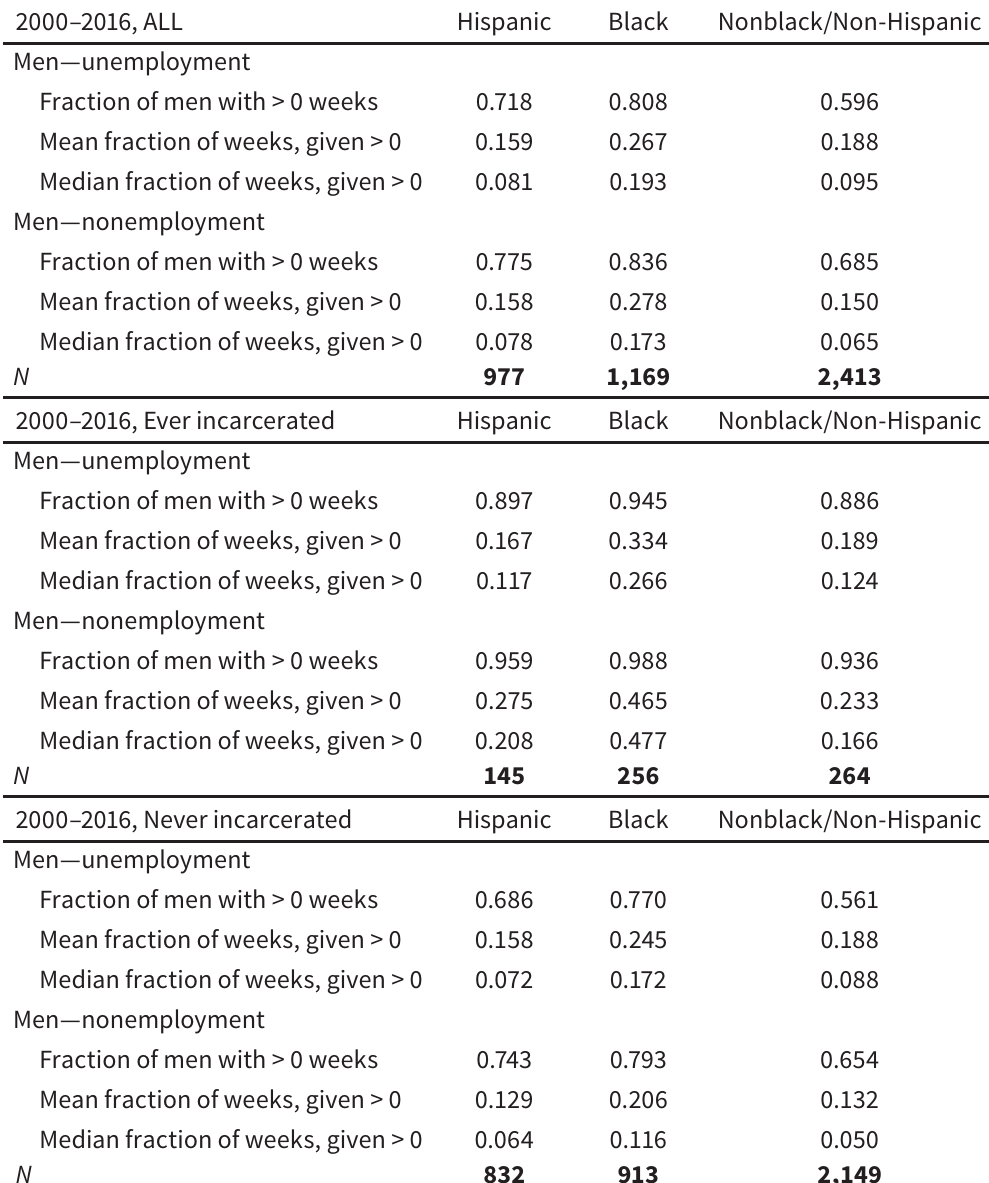
Summary statistics for unemployment and